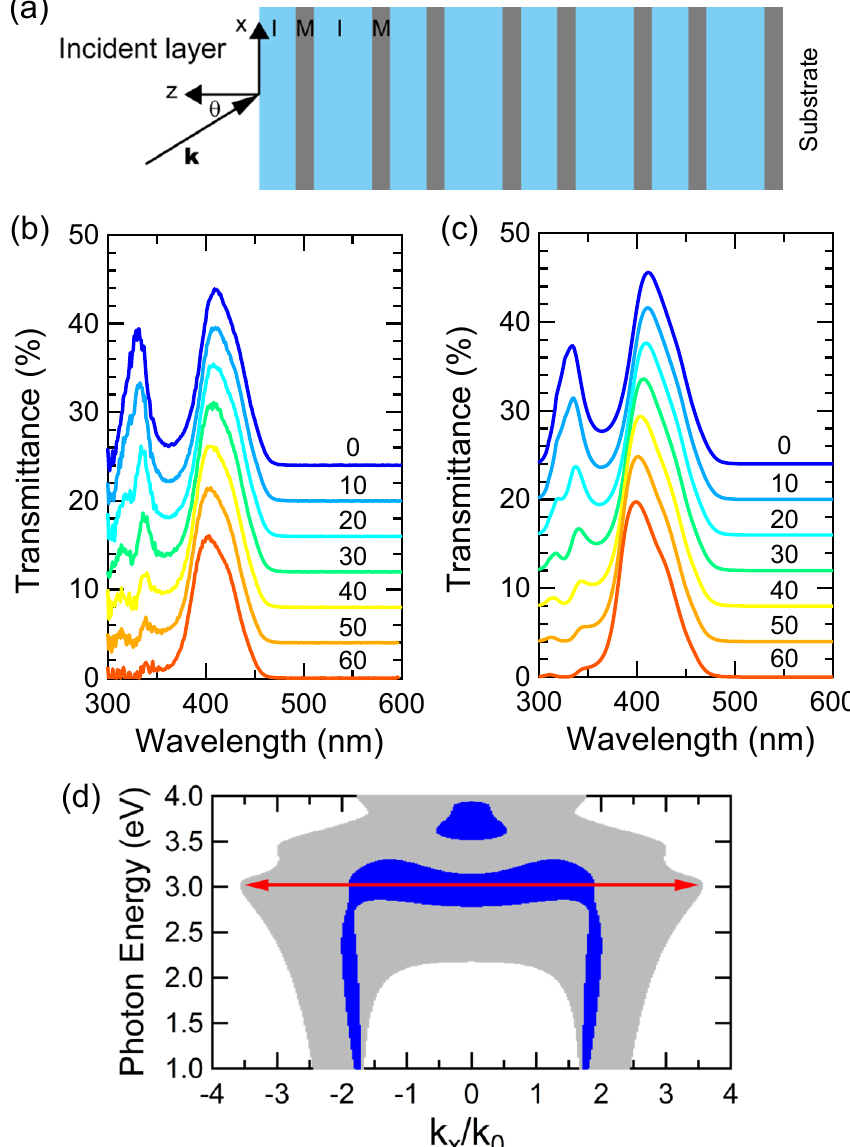
Figure 2. ( a ) Schematic of a SMIM of the four-layer unit cell, which has a transmission window at 410 nm. ( b , c ) Measured and computed T spectra under p polarization, respectively, which are shown with an o ff set for clarity. The incident angle varied from 0 ◦ to 60 ◦ at 10 ◦ steps. ( d ) Transmission Bloch band at transverse magnetic (TM) polarization. Blue and light gray correspond to the low-loss and relatively large-loss bands described in the text, respectively. Double-ended arrows indicate the peak of transmission at 3.02 eV (or 410 nm).